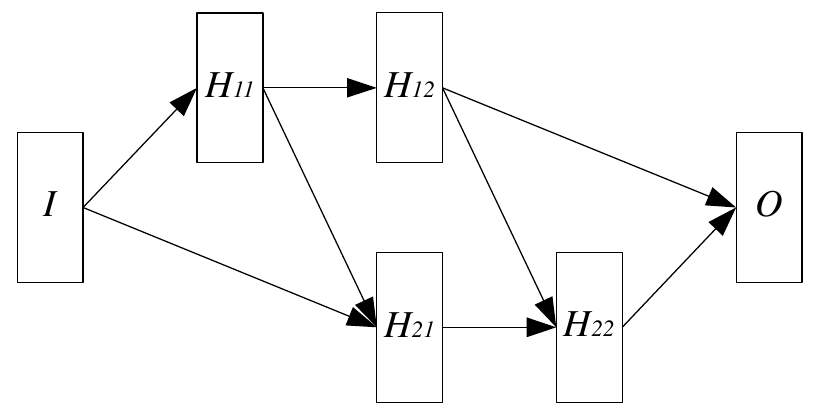
Figure 4. The proposed Nested Neural Network Architecture